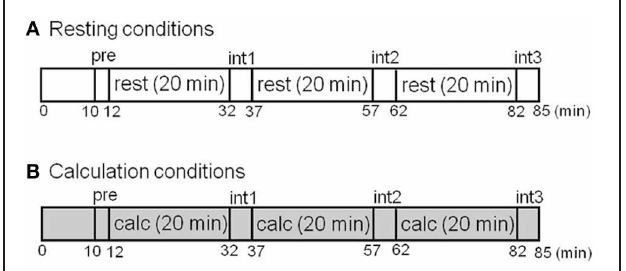
FIGURE 1 | Study protocols of test–retest measurements in the different conditions. (A) Resting condition. (B) Calculation condition. The H1 receptors were examined with [ 11 C]doxepin-PET during the resting and calculation conditions. The subjective feelings during PET scans were also measured during the 90min before the scan (pre), interval 1 (int1), interval 2 (int2), interval 3 (int3), and at the end of the scan